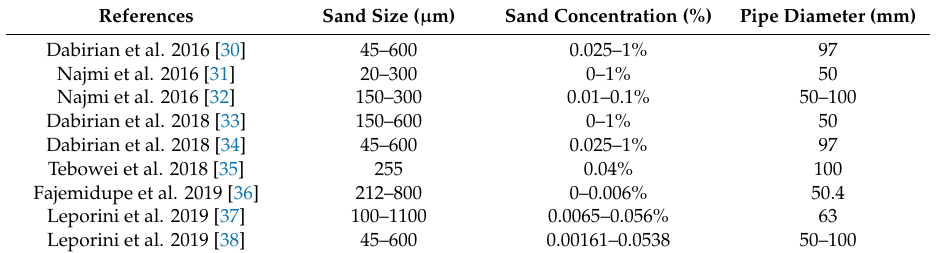
Table 1. Recent studies on sand transport and deposition in multiphase flow pipelines with a focus on low concentration